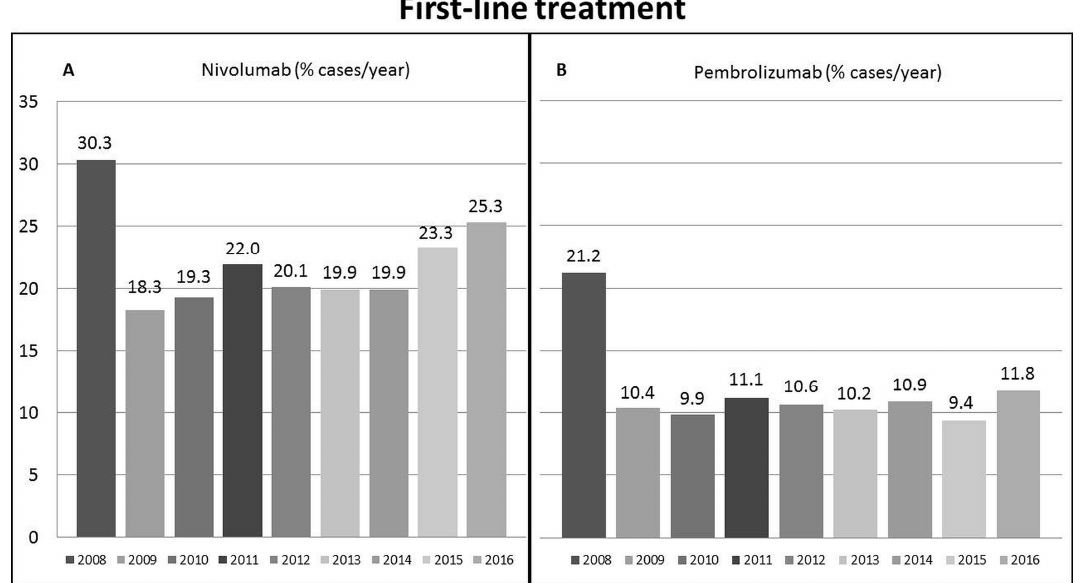
Figure 2. Proportion of patients within the Italian Liver Cancer cohort meeting the criteria for: first-line nivolumab treatment ( A ); and second-line nivolumab treatment ( B ).